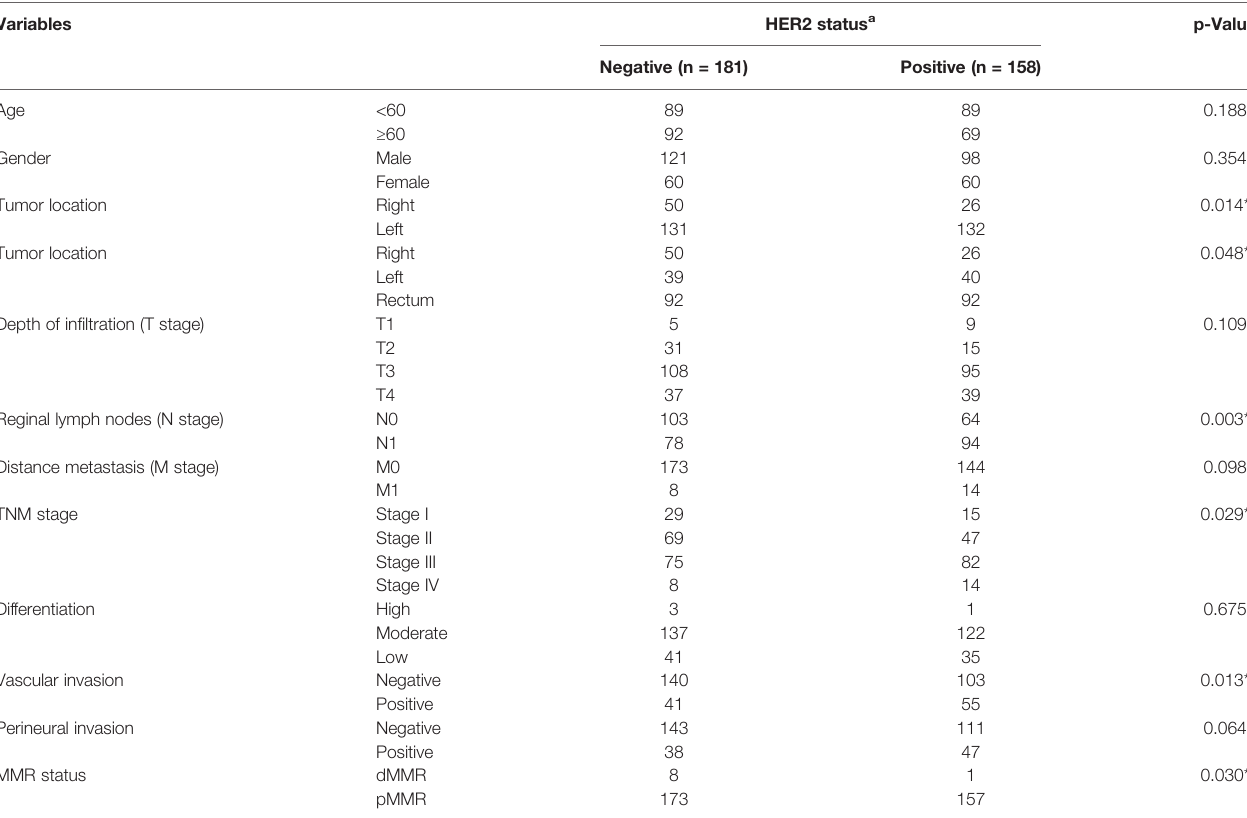
TABLE 2 | Correlation between HER2 expression and clinical parameters in the IHC HER2 2~3+ group (n = 339).